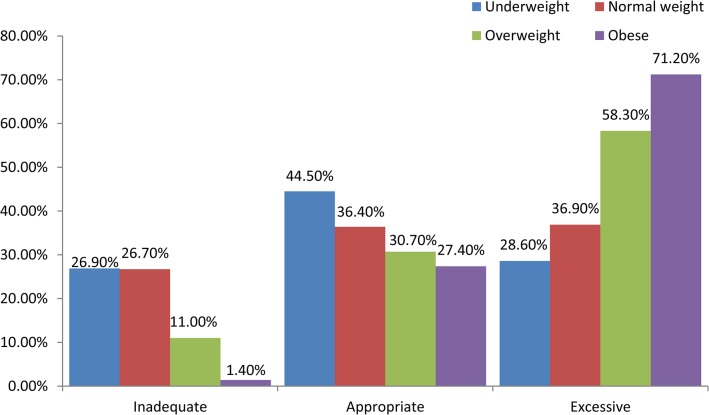
Proportion of pre-pregnancy body size satisfaction status in gestational weight gain groups.